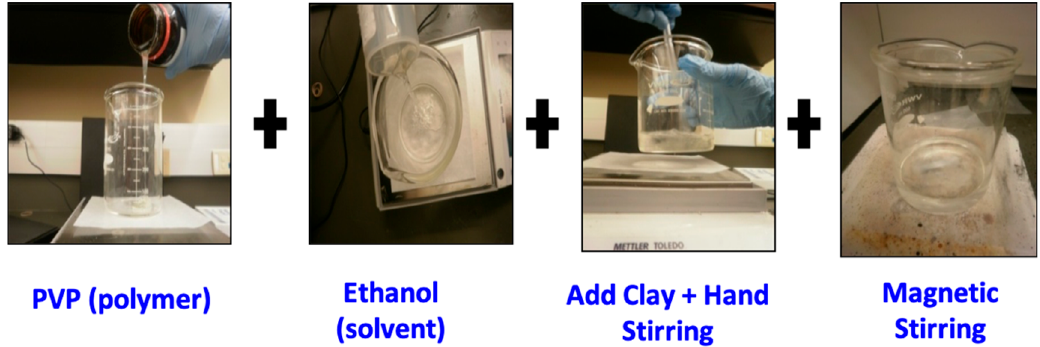
Figure 1. Polyvinylpyrrolidone (PVP)-clay films made using Solution Induced Intercalation method.